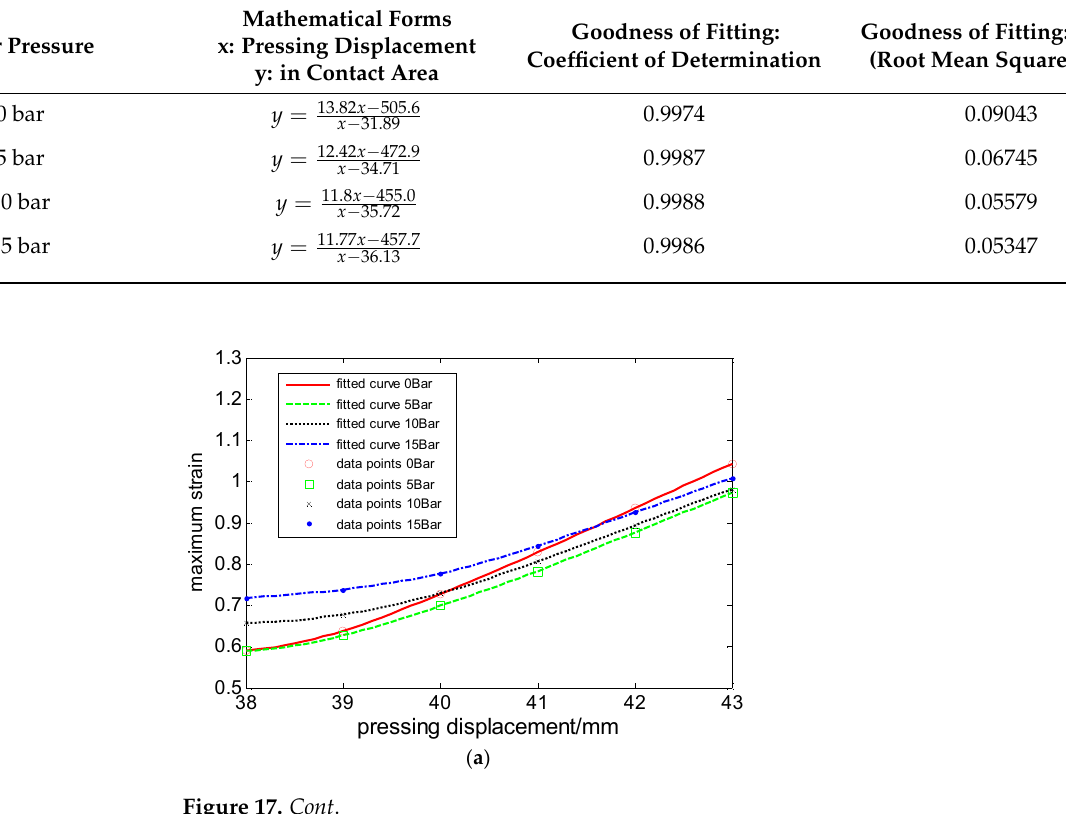
Figure 16. The area in contact of the hose inner surface when the pressing displacement is 35.20 mm, 37.26 mm, 39 mm and 40 mm, while the inner pressure is zero. The contour plot of CPRESS shows the in-contact area. Table 3. Mathematical forms and goodness of fitting of the dependency of the in contact area on the pressing displacement.